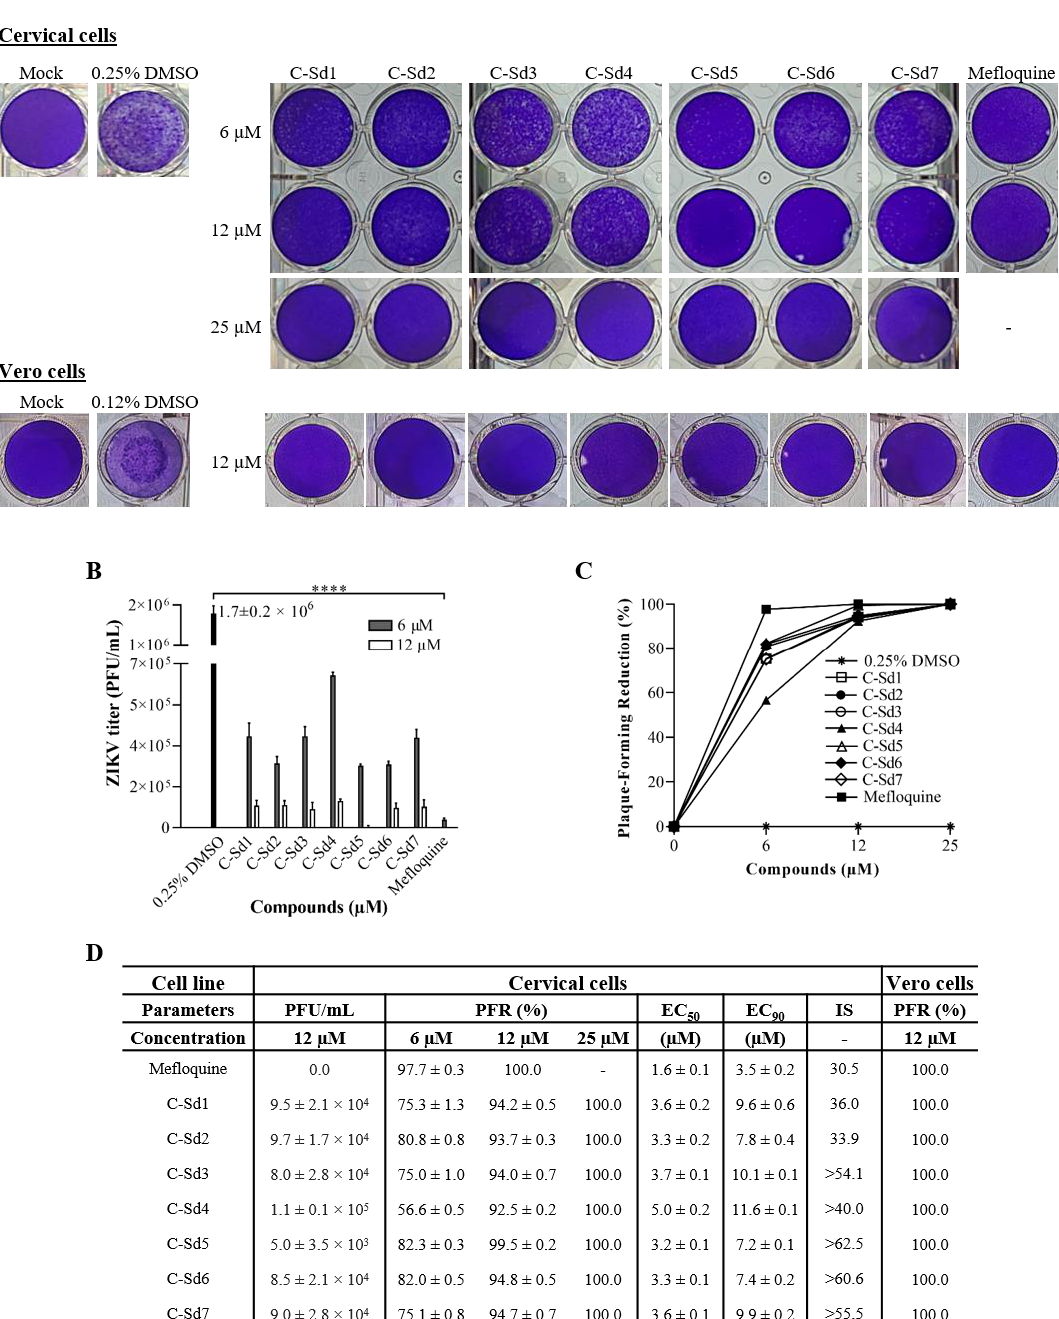
Figure 4. Evaluation of anti-ZIKV effect in cervical and Vero cell lines by plaque assay. The cervical cells were mock-infected or ZIKV-infected at MOI 10 and treated with 6, 12, and 25 µ M of C-Sds or 6 and 12 µ M of mefloquine for 48 h. The Vero cells were mock-infected or ZIKV-infected at MOI 1 and treated with 12 µ M of C-Sds or mefloquine for 48 h. ( A ) The cultures’ supernatant was collected and diluted (1:1000) for the plaque assay. The graphs represent the mean ± standard deviation of ( B ) the ZIKV titer (PFU/mL) and ( C ) the dose-response curve of PFR%. ( D ) The table summarizes the parameters of antiviral activity evaluation in cervical and Vero cells. The data are representative of 3–5 experiments run in duplicate. The statistical significance was determined by one-way ANOVA, followed by Dunnett’s multiple-comparisons test. **** p < 0.0001. The quantification of plaque-forming units (PFU/mL) in supernatants obtained from cervical cells treated with 6 to 25 µ M of C-Sds and 6 and 12 µ M of mefloquine was performed to calculate plaque-forming reduction percentage (PFR%), EC 50 , and SI values (Figure 4).